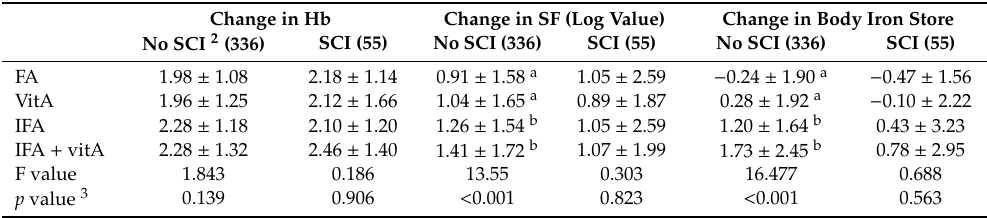
Table 2. Changes in Haemoglobin, serum ferritin and body iron store with or without sub-clinical inflammation at the end of 12 week iron supplementation 1 . Change in Hb Change in SF (Log Value)